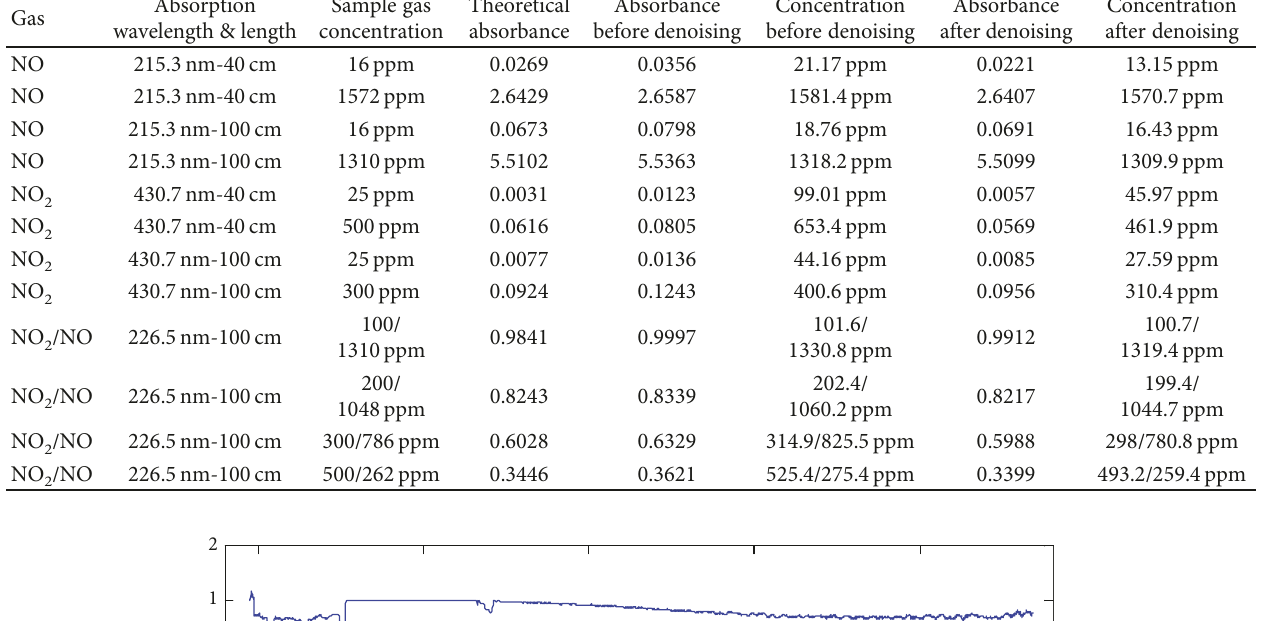
before and after noise reduction. X